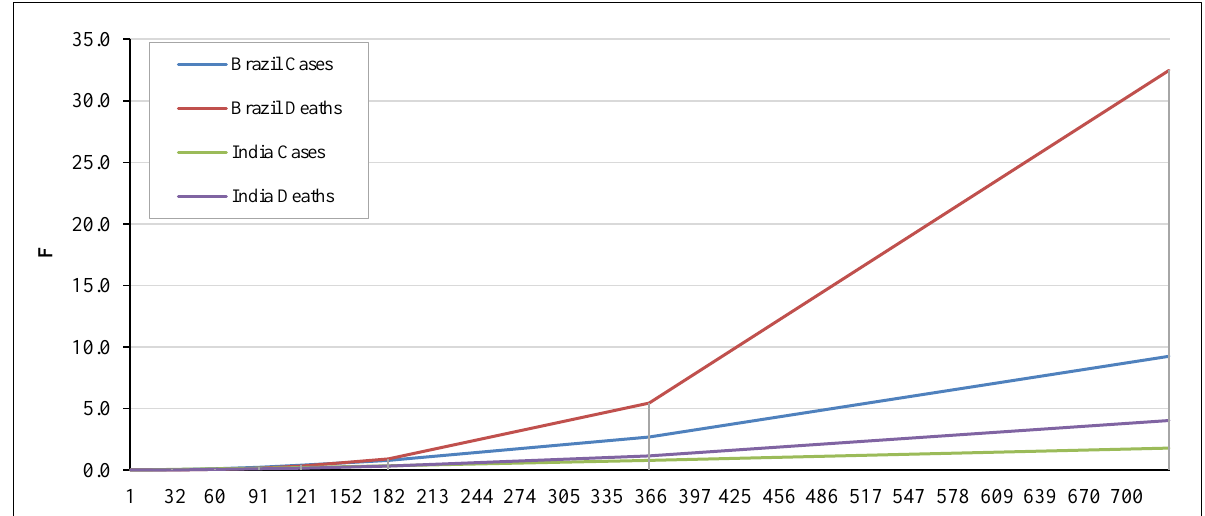
Figure 7. Dissemination rate Factor (F) at different time intervals showing the kinetics for the acceleration of the epidemic indices of two countries from two distinct WHO regions that showed major affection by COVID-19